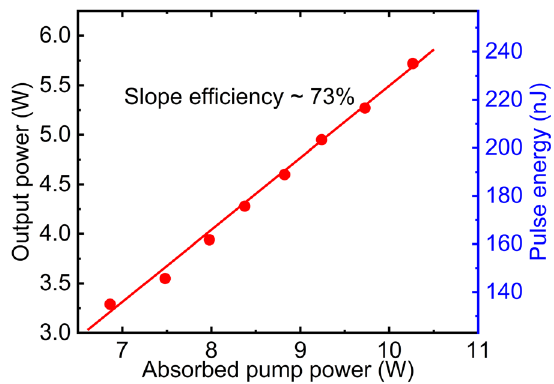
Figure 3: The output power and pulse energy as a function of absorbed pump power.